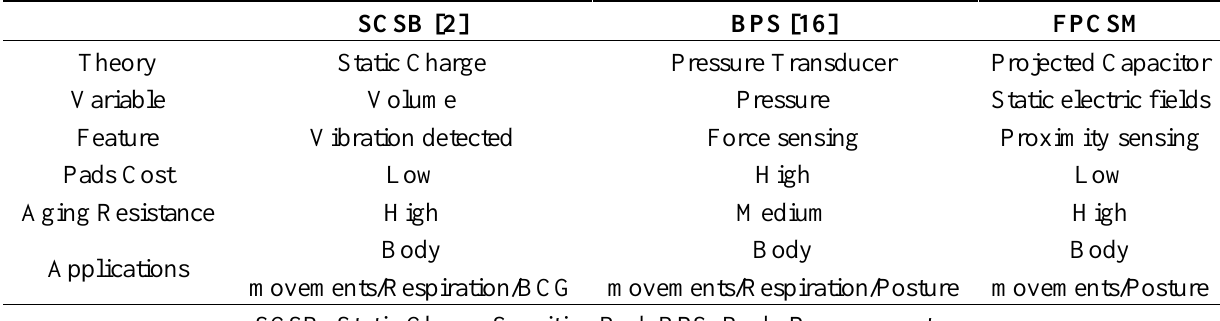
Table 1. Performance comparison with published